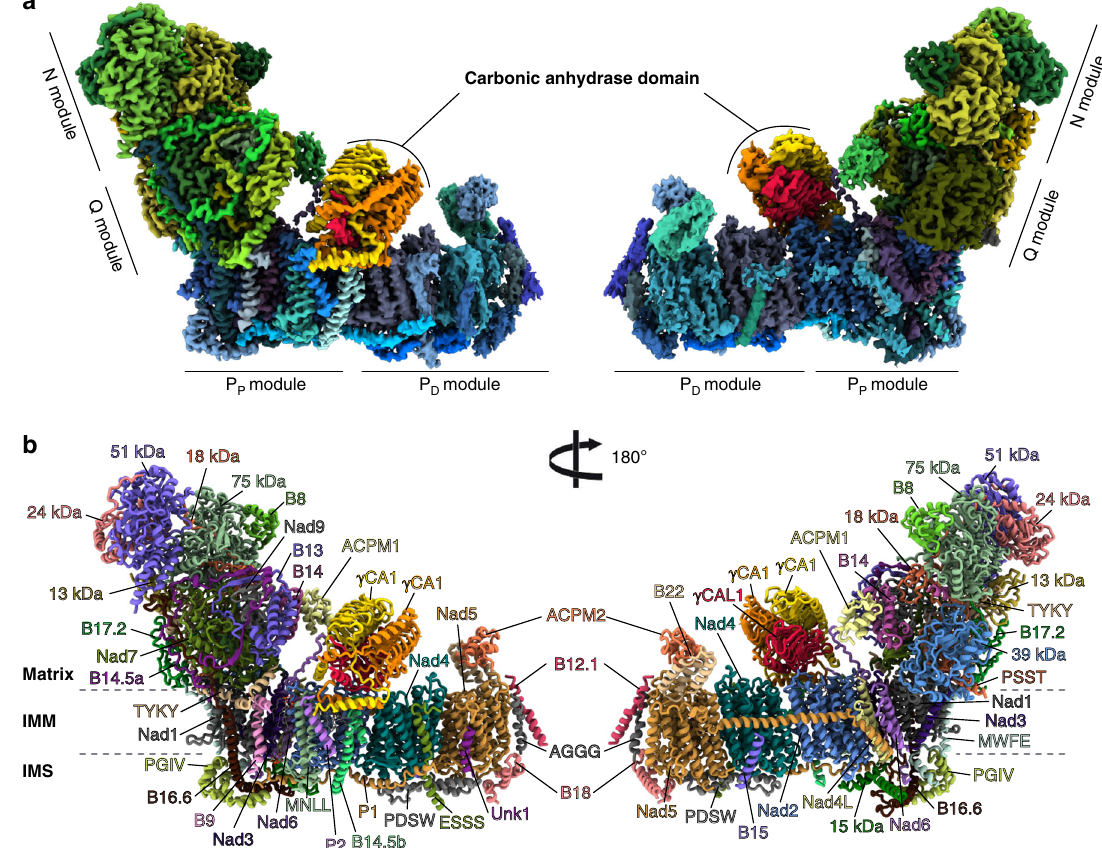
Fig. 1 Overall structure of the plant mitochondrial complex I. a Composite cryo-EM map of the complete plant complex I. The membrane part is displayed in blue shades, the matrix arm is displayed in green shades and the γ -carbonic anhydrase module is displayed in orange shades. Individual N, Q, P D , and P P modules are indicated. b The resulting atomic model, each individual 45 proteins are annotated and displayed with a different color. IMM stands for inner mitochondrial membrane, IMS inter-membrane